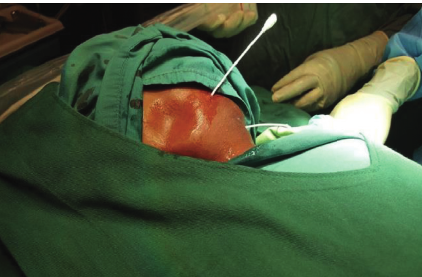
Figure 5: Complete aspiration of the cystic contents of the